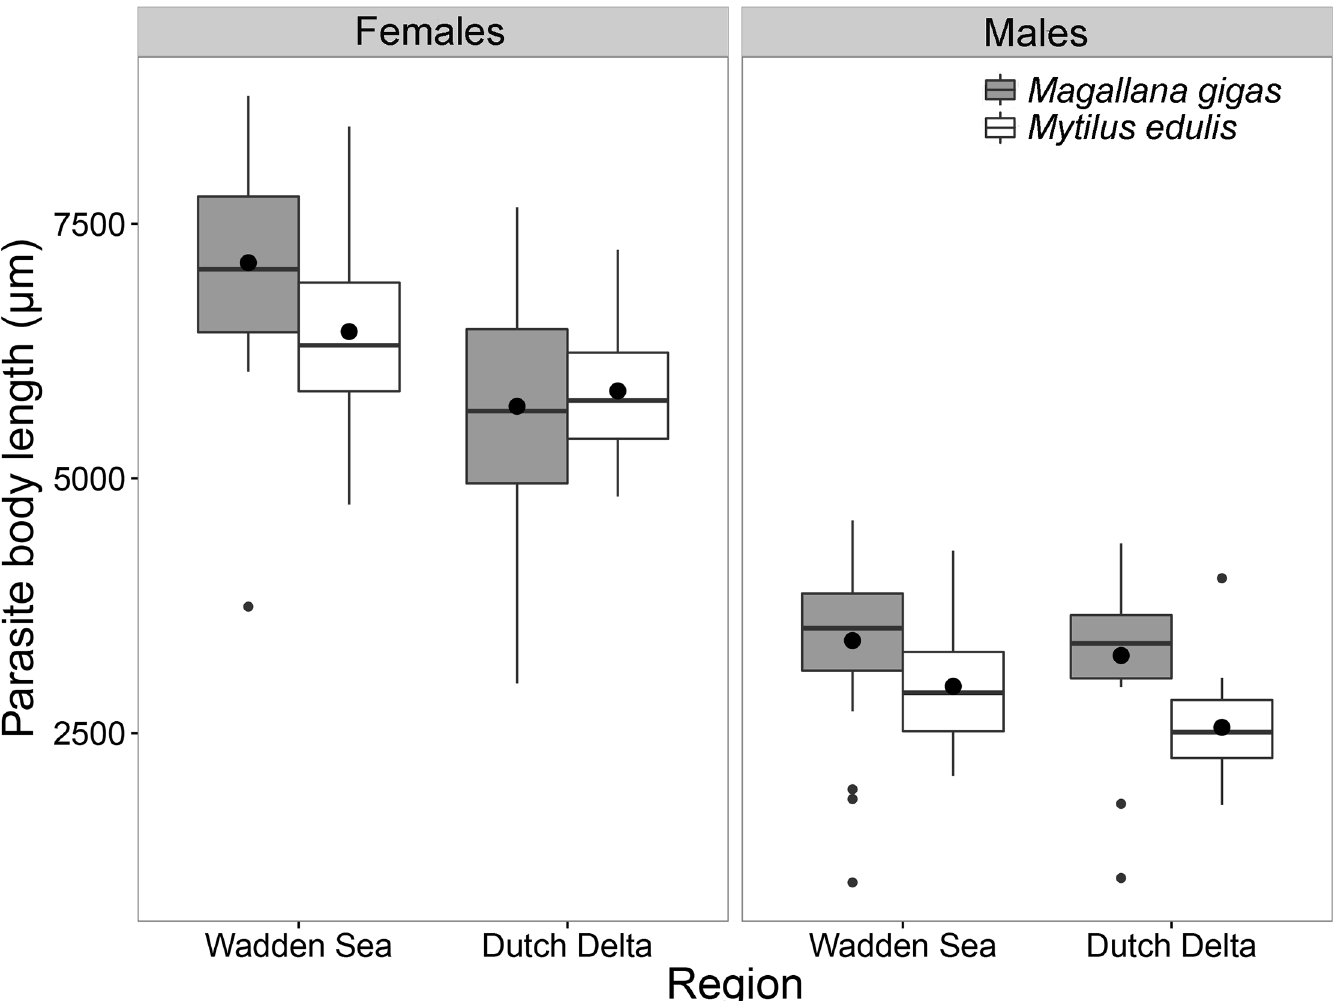
Fig 3. Boxplots of Mytilicola orientalis body length (μm) in both host species. Female (left) and male (right) copepods originating from oysters ( Magallana gigas ) in grey and from mussel ( Mytilus edulis ) hosts in white, from the Dutch Delta and Wadden Sea. The boxes represent the interquartile range, the whiskers denote the lowest and highest values within the 1.5 interquartile range, the black line in each box denotes the median, the large black dots represent the mean and the smaller dots outside the boxes are outliers.